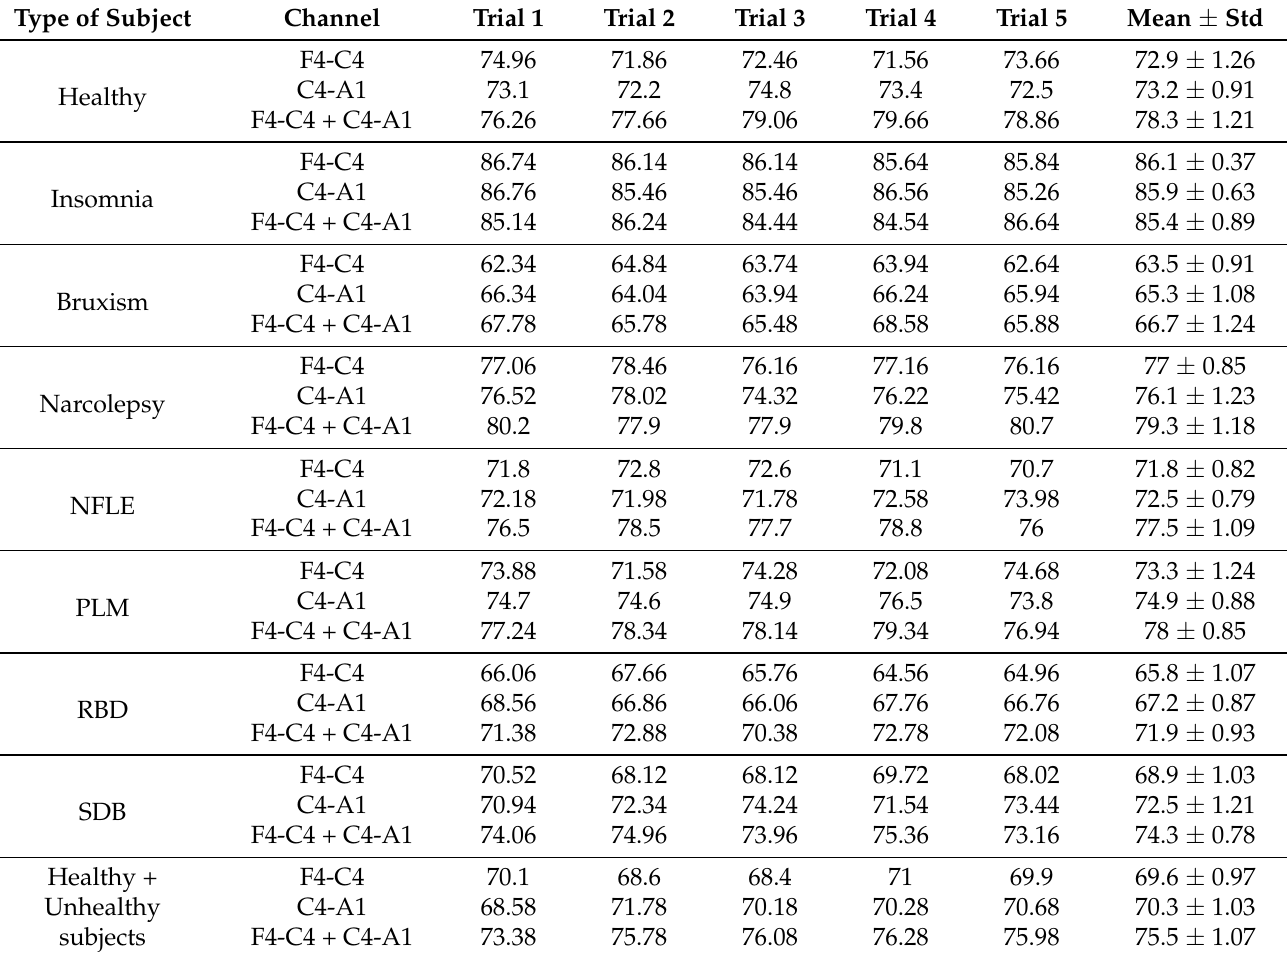
Table 7. Summary of classification average accuracy obtained during each trial using the EBT classifier with 10-fold cross validation